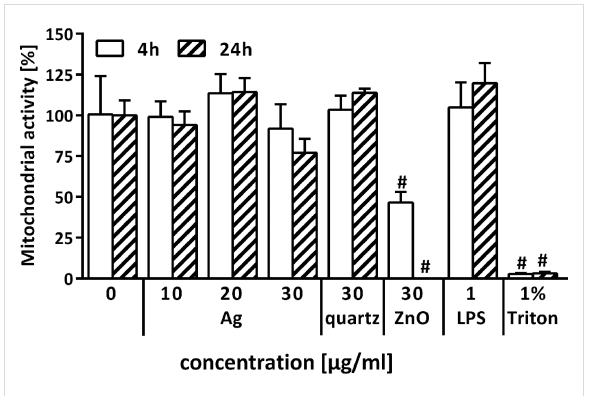
Figure 5: Cytotoxic response of PCLS as measured by WST-1 conver- sion after 4 and 24 h incubation ( n = 5; # p < 0.05 vs control deter- mined by ANOVA on ranks with post hoc Student–Newman–Keuls